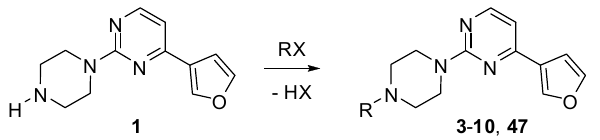
Scheme 2. Synthesis of substituted pyrimidines 3 – 10 and 47 (see Table 1).